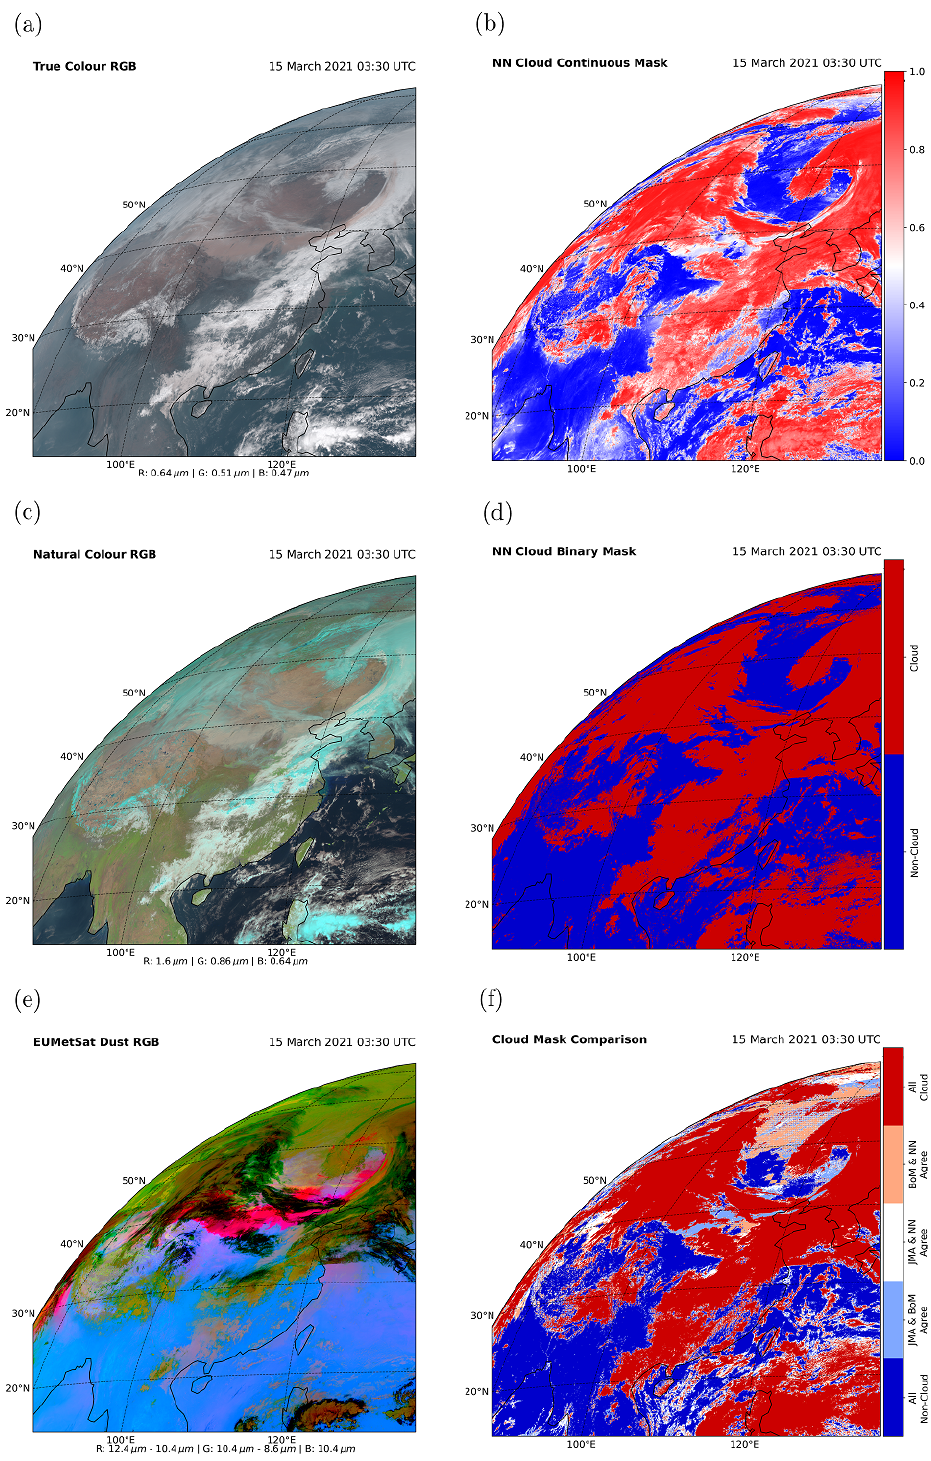
Figure 8. A partial-disk AHI scene covering southeast Asia for 15 March 2021 at 03:30UTC. A total of three RGB false-colour composites of the scene are presented in the left-hand column, showing (a) true-colour, (c) natural-colour and (e) dust RGBs. The top, middle and bottom panels of the right-hand column show (b) the NN continuous cloud mask, (d) NN binary cloud mask and (f) a comparison of the three binary masks for the